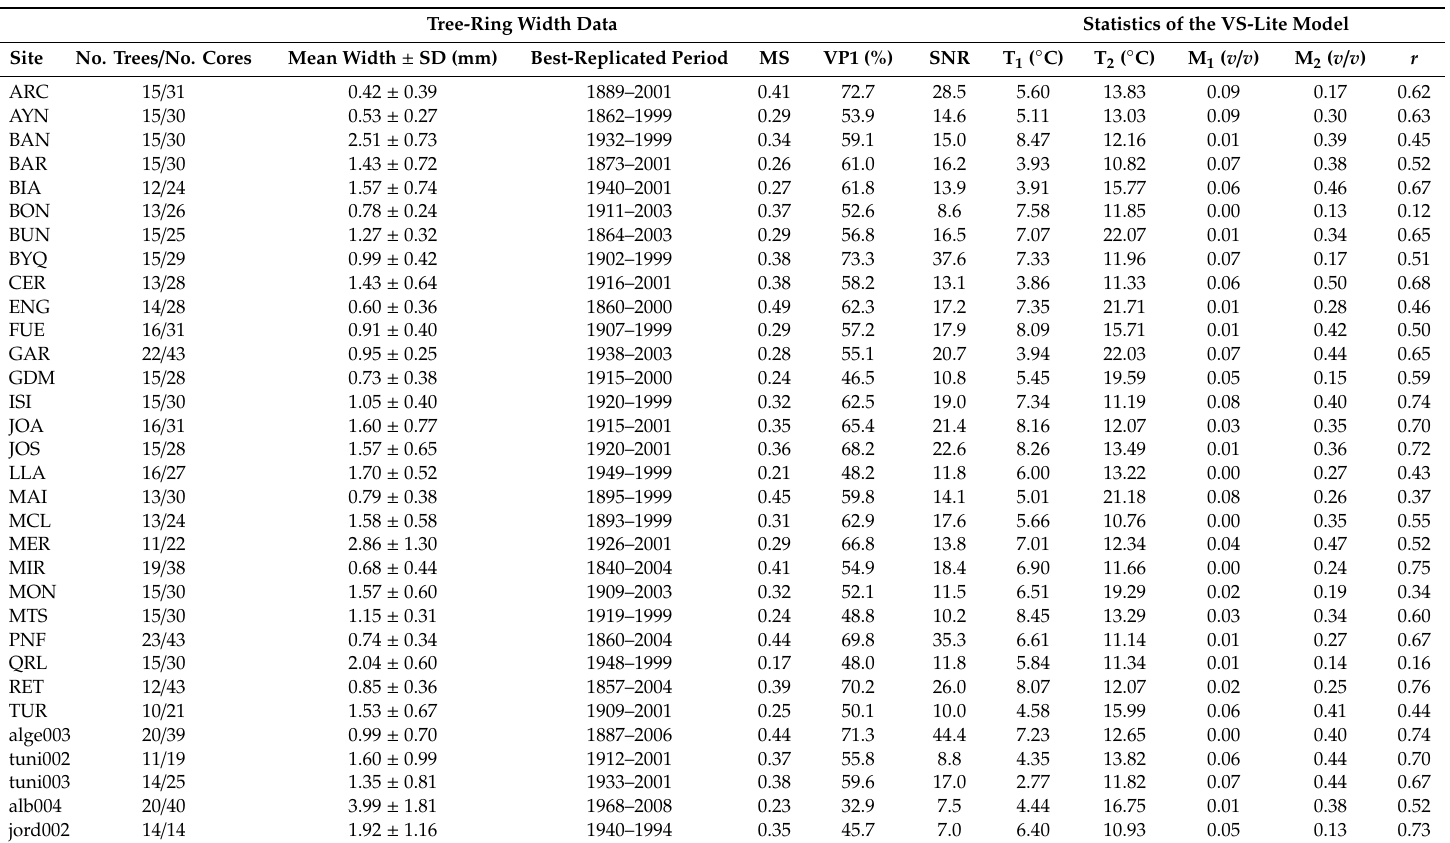
Table 1. Tree-ring width and VS-Lite statistics for the study sites. Mean ring widths were calculated for the common period 1950–1999, except for jord002 (1971–1994). The EPS is the Expressed Population Signal, and the best-replicated period was defined by EPS > 0.85. The MS is the mean sensitivity. The percent variance accounted for the first principal component (VP1), and the signal-to-noise ratio (SNR) measures the internal coherence shared by all the series within a site. Regarding the VS-Lite model parameters, two of them determine when growth will not occur (T 1 for temperature and M 1 for soil moisture), and the other two determine when growth is not limited anymore by climate constraints (T 2 for temperature and M 2 for soil moisture). The last column shows the correlation ( r ) between observed and VS-Lite simulated ring-width